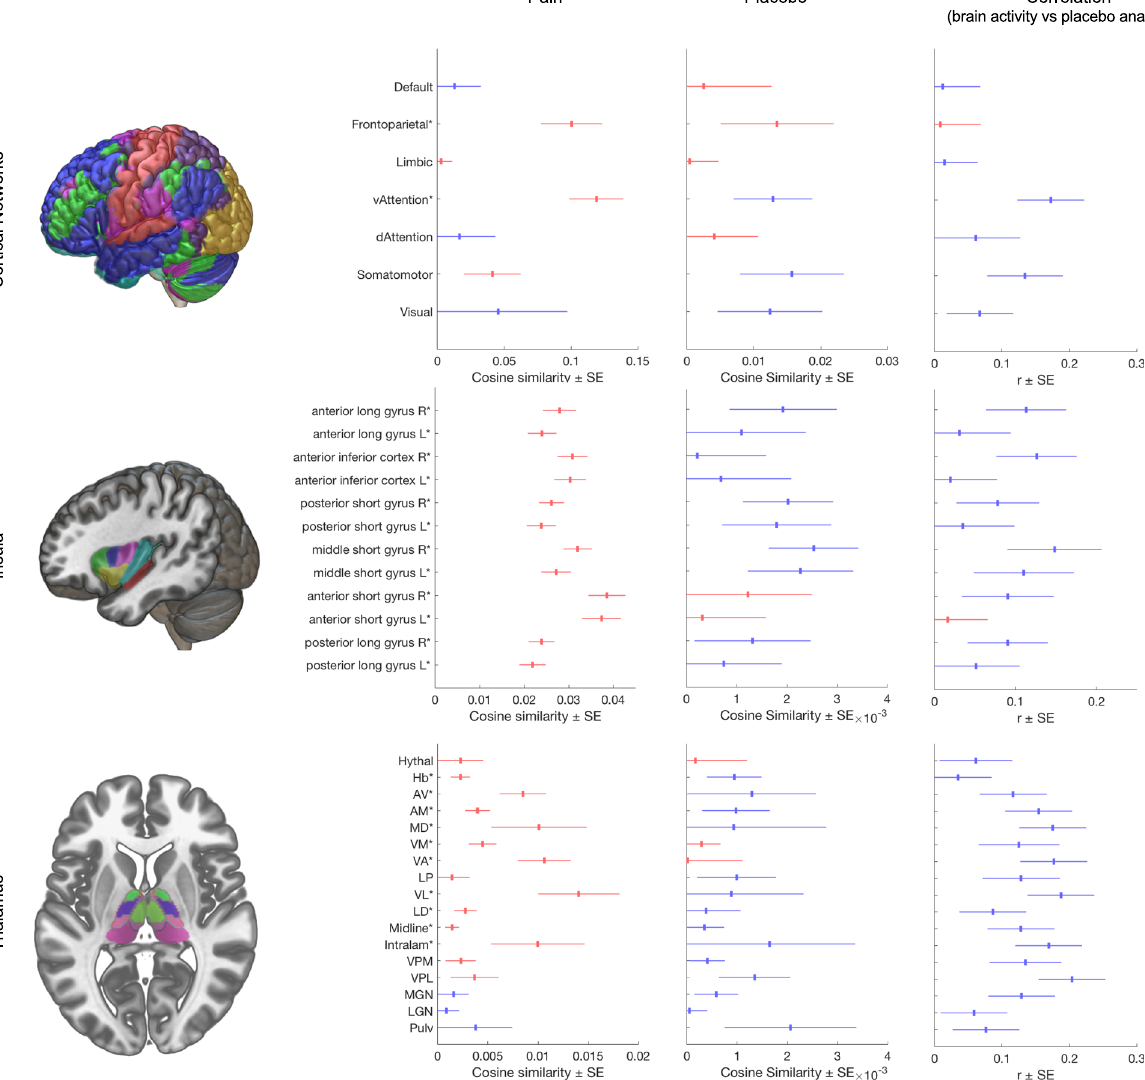
Fig. 4 Similarity-based analysis of brain activity in functional cortical networks, insula, and thalamus. Column 1 (header): Depiction of atlases: Row 1: whole-brain cortical networks of functional connectivity 14 , Row 2: insular sub-regions 66 Row 3: thalamic nuclei 67 . See Supplementary Fig. 14 for further details. Column 2: Mean (±SEM) cosine similarity (c) of pain-related activity, n = 603 from 20 independent studies; Column 3: Mean (±SEM) cosine similarity ( c ) of placebo-induced changes in pain-related activity (Column 2); all: n = 603 from 20 independent studies. Column 4: Correlation (Pearson ’ s r ± SEM) between behavioral placebo response and cosine similarity estimates of placebo-related activity; n = 460 from 18 independent studies. In Columns 2 and 3, red and blue colors denote increased and decreased pain-related activity, respectively. In Column 4 red and blue shades denote increased and decreased activity associated with larger placebo analgesia, respectively. Asterisks (*) denote signi fi cant differences from zero, according to two-sided t - tests ( p < 0.05, uncorrected for multiple comparisons). Source data (results as 3d-volumes) are provided at https://osf.io/n9mb3/. Hythal Hypothalamus, Hb Habenular, AV anterior ventral, AM anterior medial, MD mediodorsal, VM ventral medial, VA ventral anterior, LP lateral posterior, VL ventral lateral, LD lateral dorsal, Intralam intralaminary, VPM ventral posterior medial, VPL ventral posterior lateral, MGN Medial Geniculate Nucleus, LGN Lateral Geniculate Nucleus, Pulv